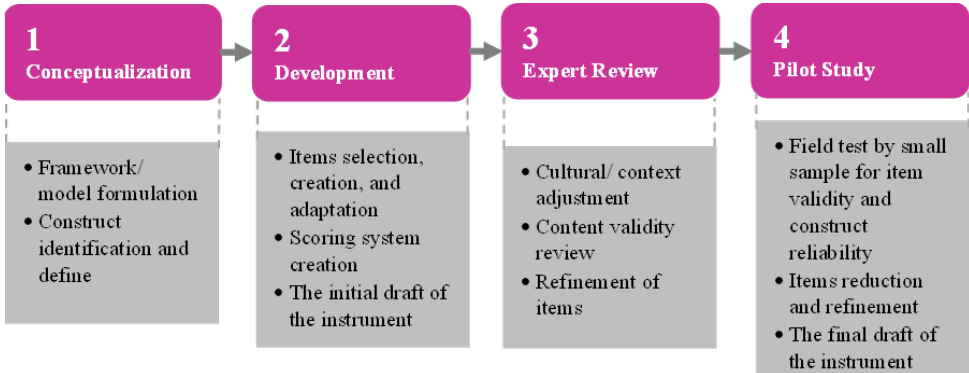
Figure 2. Instrument development and validation procedure.